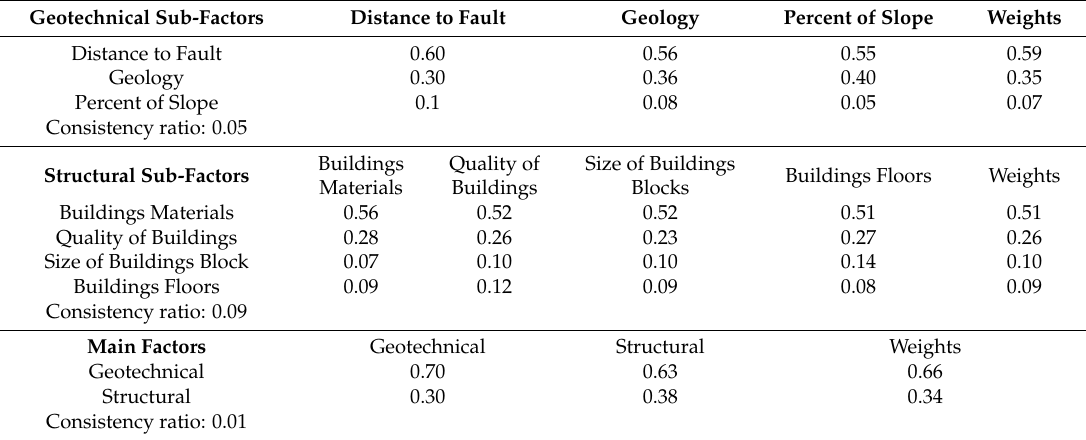
Table 8. List of the dataset and computed weights and Consistency ratio of the data layers.